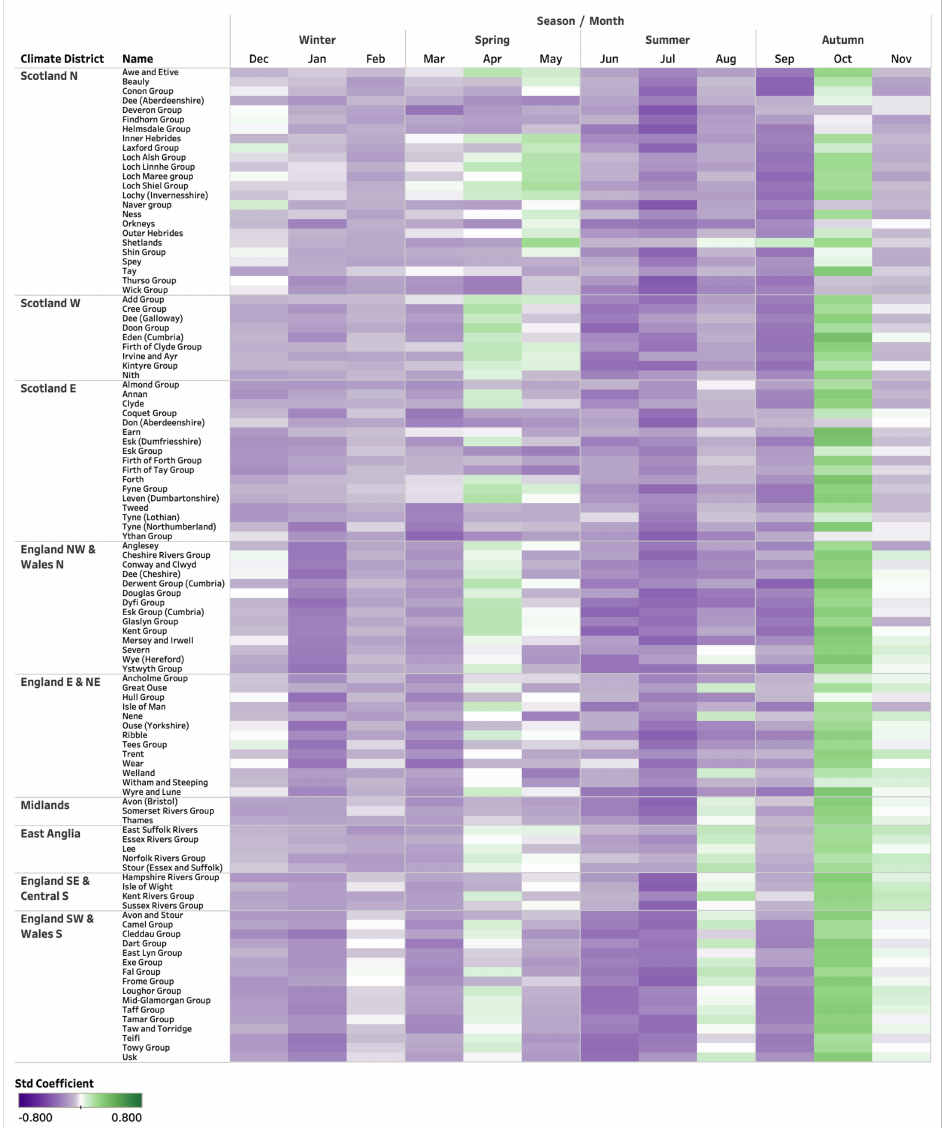
Figure 9. Standardised coefficient values for the POL index from the multivariate regression